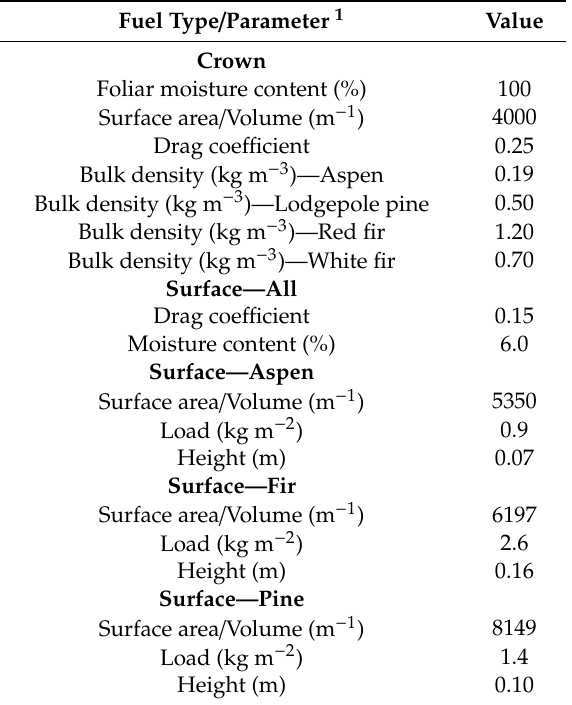
Table 1. Surface and fuel parameters used to populate Wildland urban-interface Fire Dynamics Simulator (WFDS)